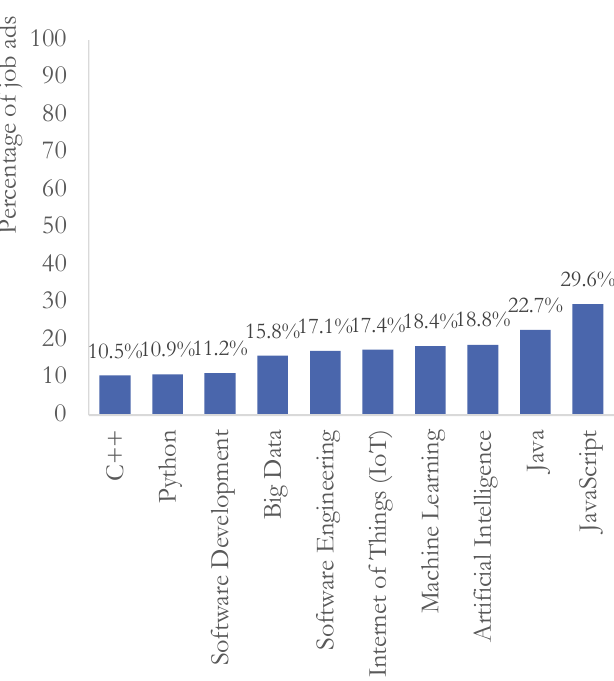
Figure 6. Top hard skills required in Australian blockchain- related job ads between August 2017 and August 2018. Source: BGT data [7]